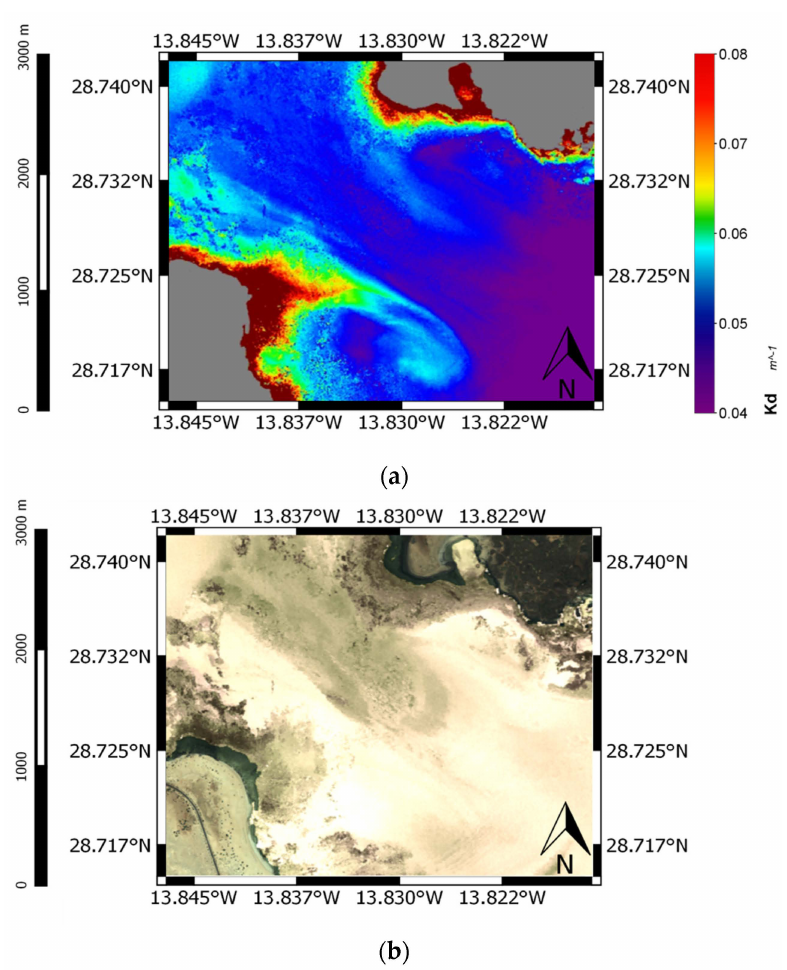
Figure 9. Corralejo and the Lobo Island (Fuerteventura Island), biosphere reserve and natural protected area: ( a ) k d ( 490 ) coefficient map; and ( b ) color composite of the seafloor albedo obtained using the new deglinting integrated in the RTE inversion